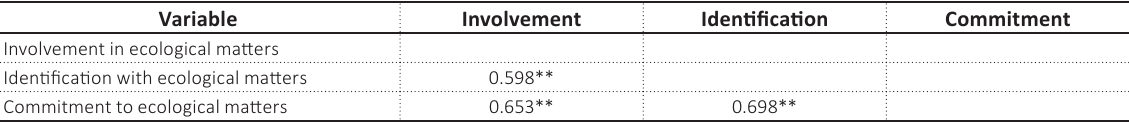
Table 5. Pearson correlation of loyalty to ecology-related causes